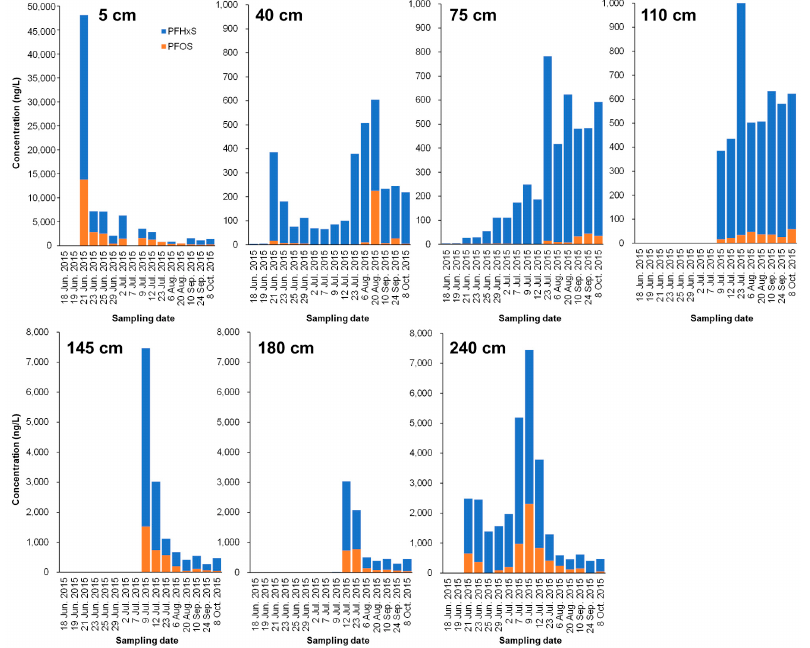
Figure 4. Time-course change of PFHxS and PFOS concentrations (ng/L) in lysimeter leachate collected from different depths (5, 40, 75, 110, 145, 180, and 240 cm). The leachate samples could not be obtained for all sampling dates.